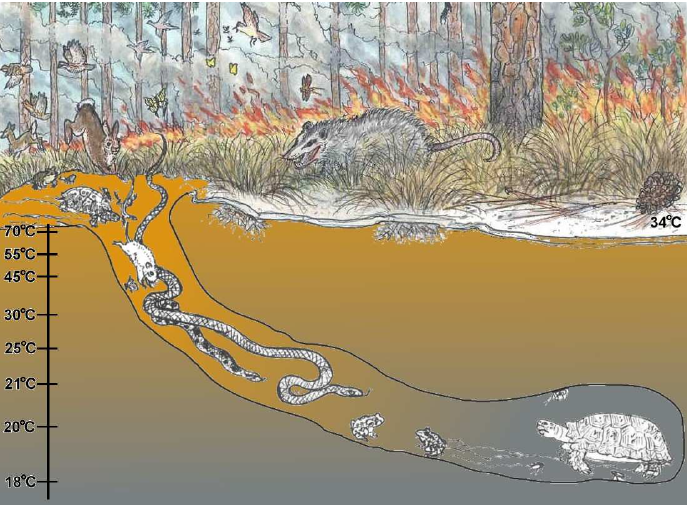
Figure 5. Animals know how to escape fire